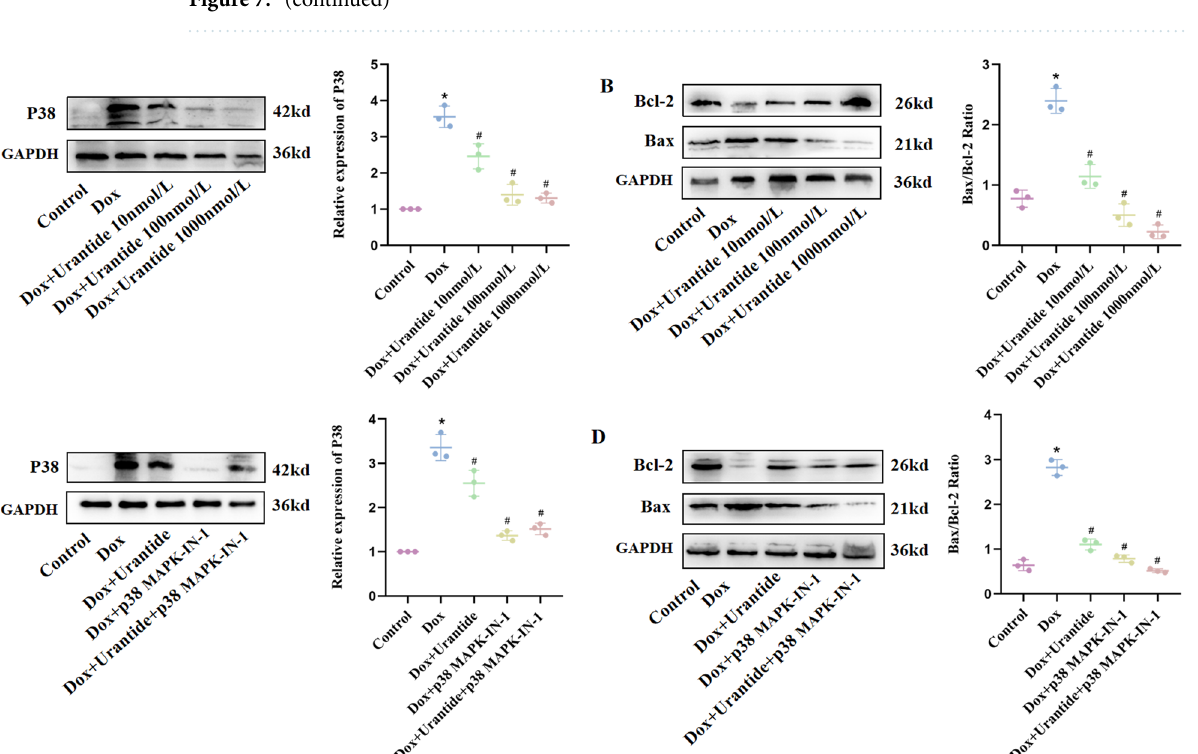
Figure 8. The protective effect of Urantide on DOX-induced primary cardiomyocytes depend on the down- regulation of the p38 MAPK pathway. ( A , C ) The expression level of the p38 MAPK pathway was downregulated in primary cardiomyocytes with Urantide or inhibitor-treated compared to DOX group. ( B , D ) The relative expression of Bcl ‐ 2 and Bax in five groups. *P < 0.05, vs. the control; # P < 0.05 vs. the